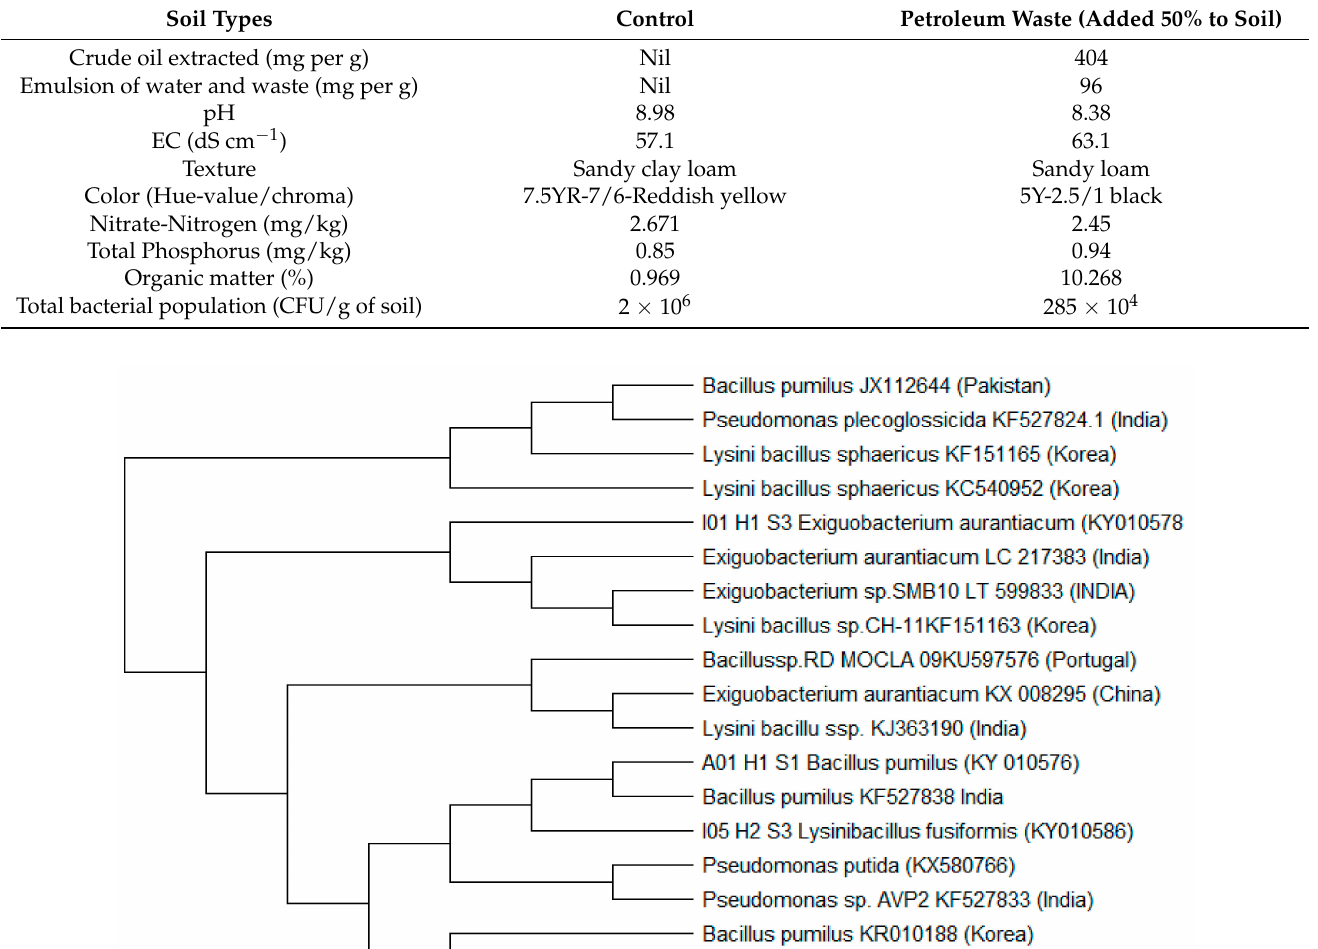
Table 2. Control and petroleum waste physicochemical and total bacterial population (CFUs/g of soil).